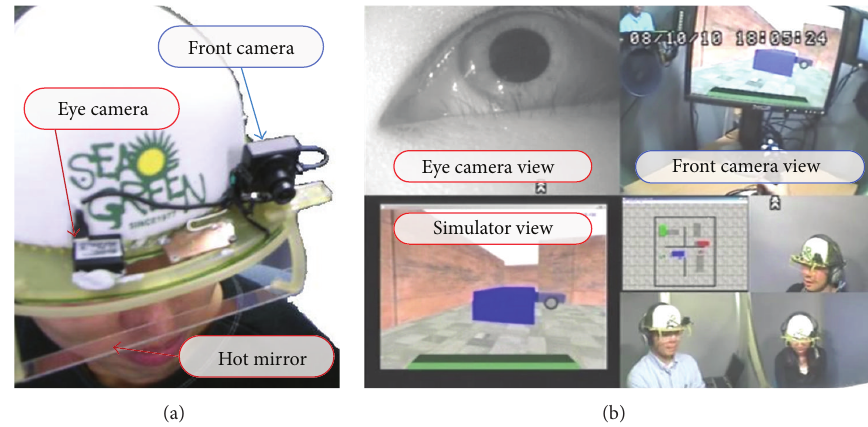
Figure 3: (a) Head set of gaze detection and (b) sample of recorded movie.